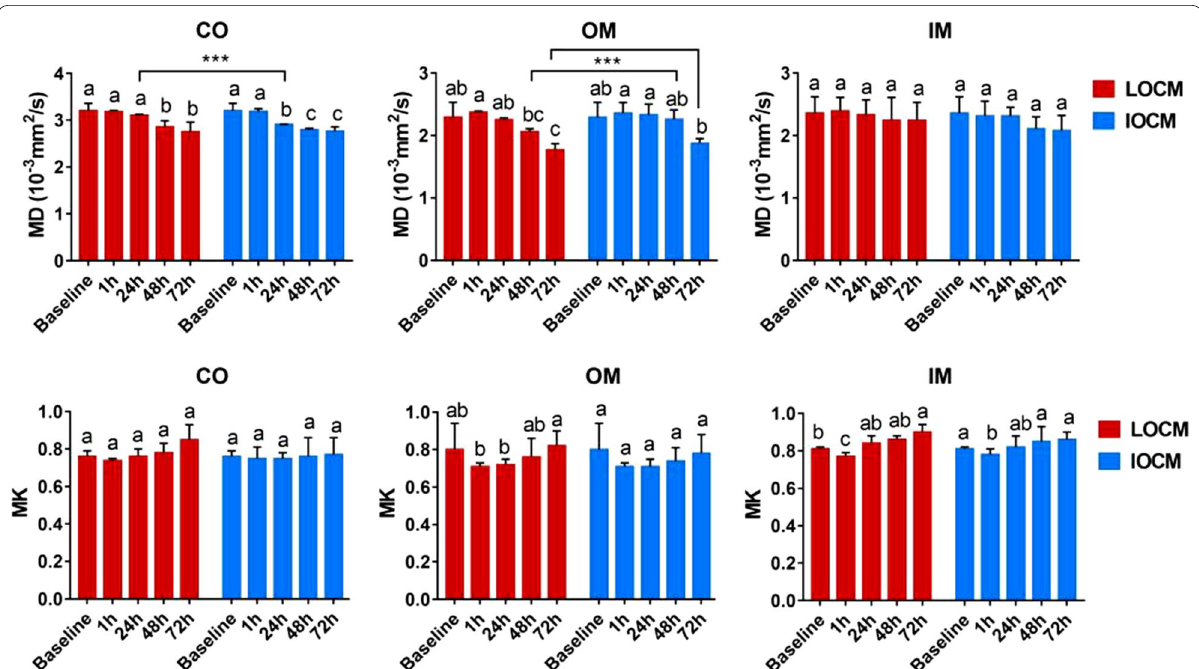
Fig. 4 The comparison of MD and MK at all anatomical layers at each time point was compared between the LOCM group and the IOCM group. Different lowercase letters on the column represent significant differences between groups at the 0.05 level. ***Represents a significant difference between groups at the level of 0.001